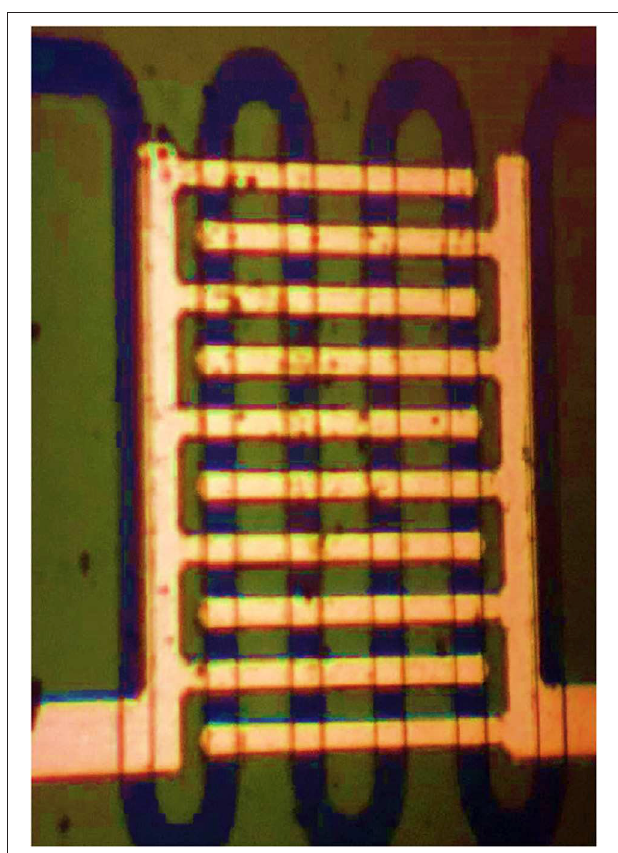
FIGURE 3 | The planar gas